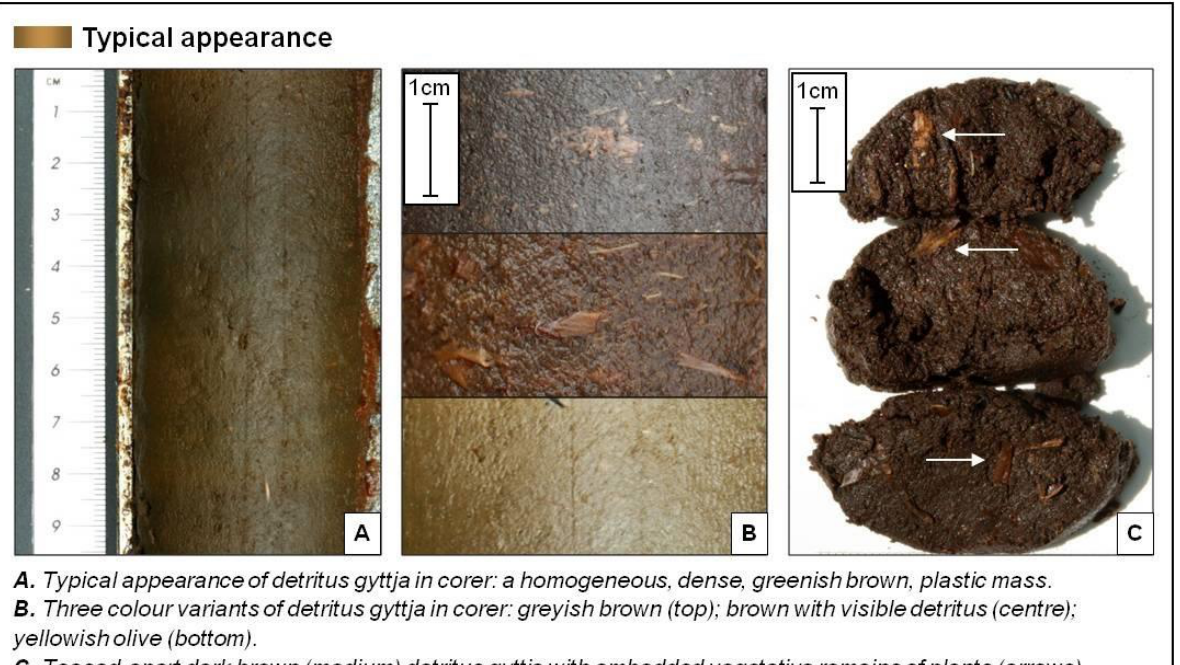
Figure 4. Excerpt from the portrait of detritus gyttja, after Meier-Uhlherr et al. (2011) (page 2), translated from